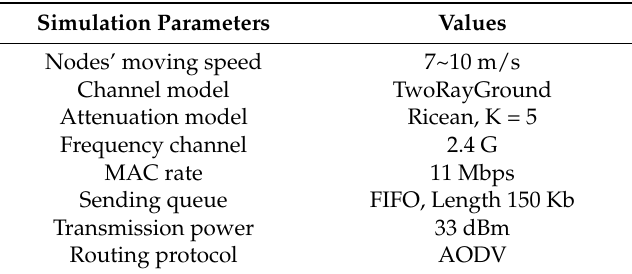
Table 1. Basic parameters of the scenario.